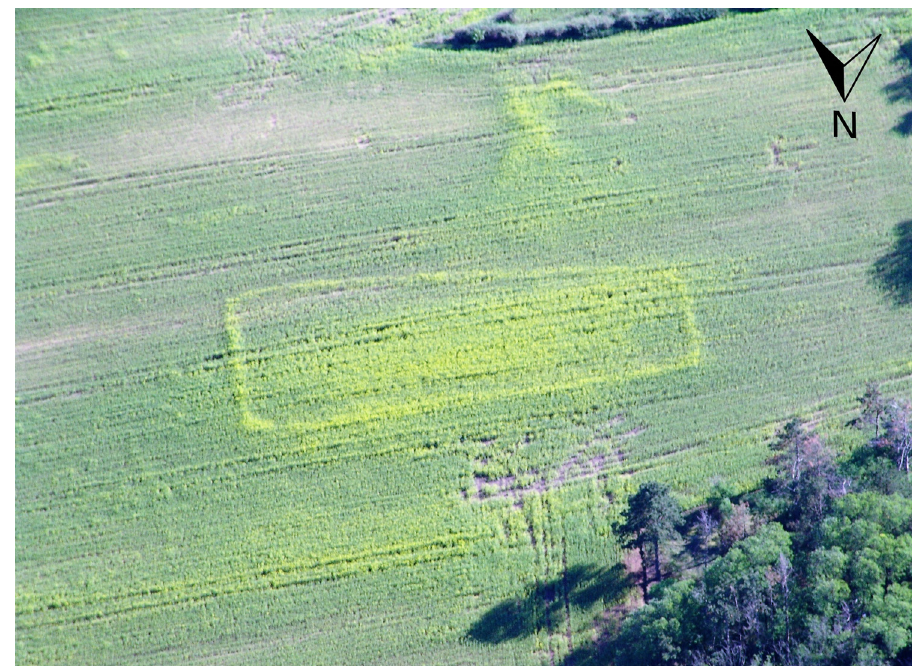
Figure 2: Ní ž ebohy ( Litom ěř ice district ) . Arial photograph of cropmark of a long barrow, the narrower end oriented to West ( after Gojda, 2019, Figure 5.125 ) .